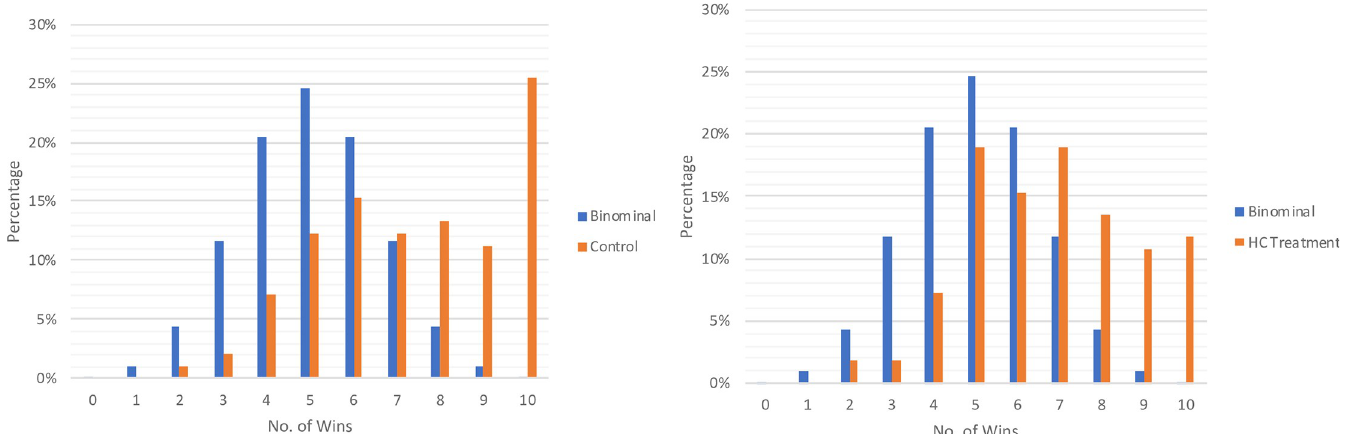
PLOS ONE | https://doi.org/10.1371/journal.pone.0238241 September 10,